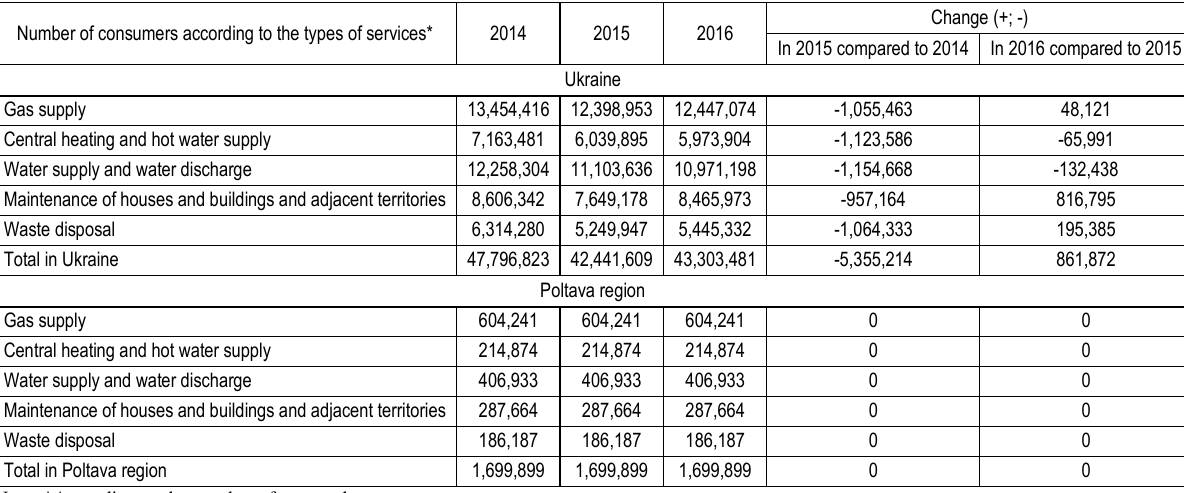
Table 2. Increase in the number of consumers of housing and utility services in the period 2014−2016 Number of consumers according to the types of services*